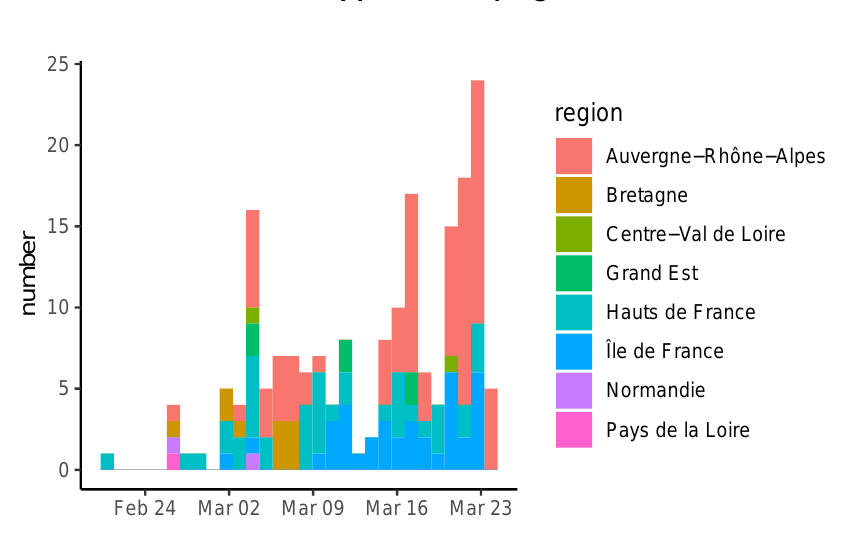
Figure S1 – Sampling date and region. List of samples collected, analysed and shared via GISAID by the two French National Reference Centers (CNR) as of Apr 4, 2020.